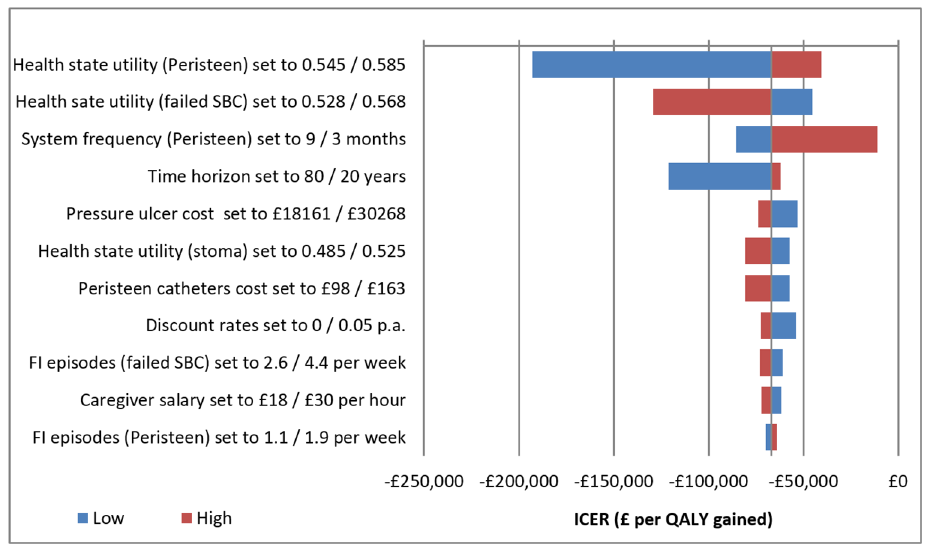
Fig 2. Tornado diagram.